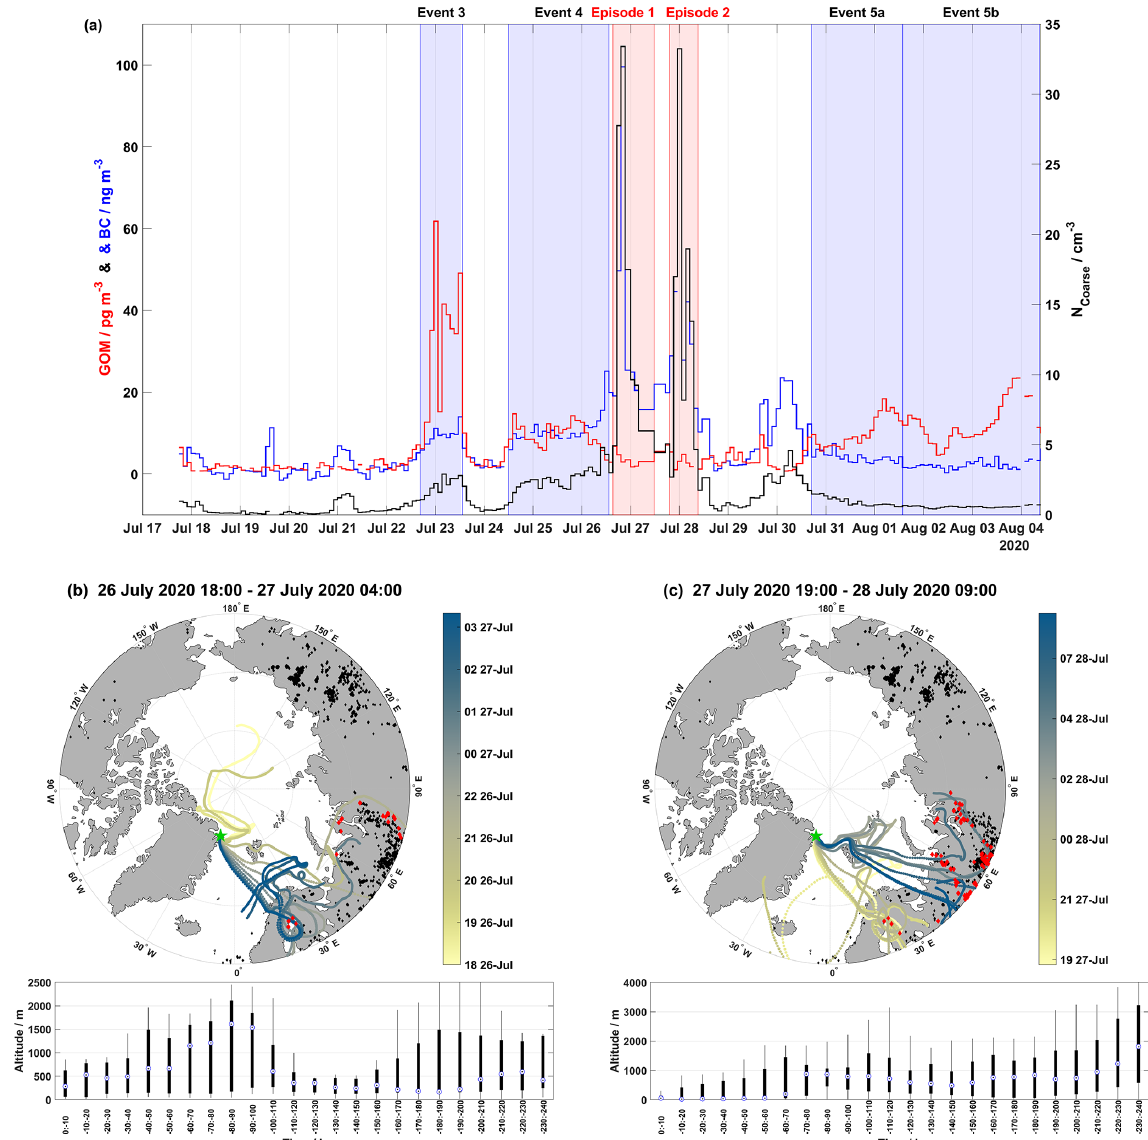
Figure 6. Time series demonstrating the full scale of N Coarse and BC, along with GOM concentrations shown in (a) . The event periods are shaded in blue while the two episodes are shaded in red. Map of air mass back-trajectories during (b) the first episode and (c) the second episode of elevated N Coarse and BC concentrations. The top panels in (b) and (c) show individual hourly trajectories are colored-coded by the arrival date at Villum as indicated by the color bar (the date format is HH dd-MMM): active fires during each event are in black, and active fires intersecting trajectories within 2 ◦ latitude and longitude and within 2h are in red (active fires from the previous 10d before the start of an event were included to reflect the trajectory length). The position of Villum is marked by the green star. The bottom panel displays boxplots of the altitude for each event binned in increments of